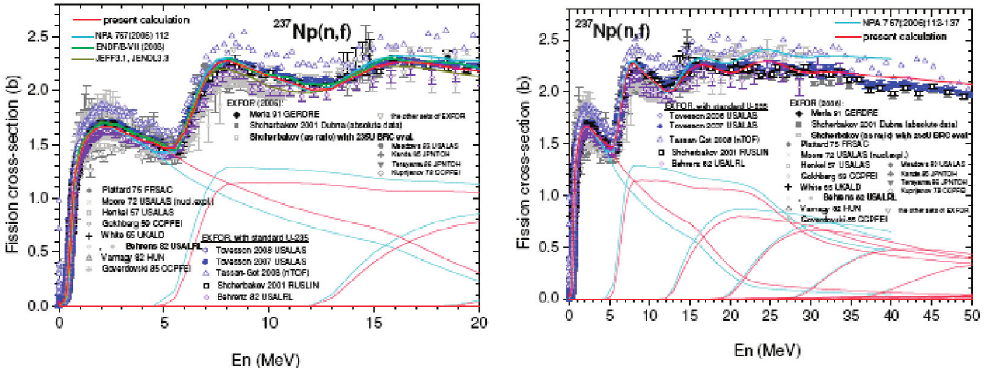
Fig. 3. The fission cross section for 237 Np(n , f), left part in the incident neutron energy range up to 20MeV, right part up to 50MeV. The coloured full lines give the contribution of the di ff erent chances and are compared to older